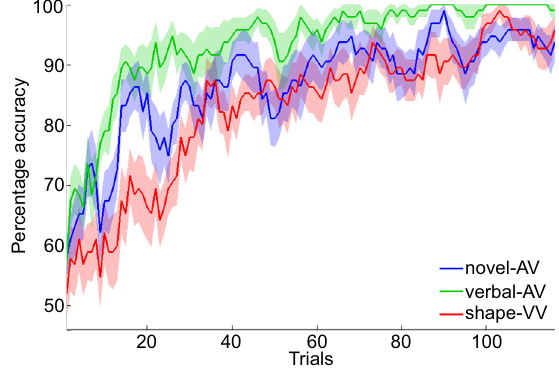
Figure 3. Percentage accuracy for the associative learning tasks. Moving average of mean percentage accuracy for trials on the novel- sound auditory-visual (novel-AV), the verbal-visual (verbal-AV), and the visual-visual with red shapes (shape-VV) learning tasks. Shaded areas depict SEM along the moving